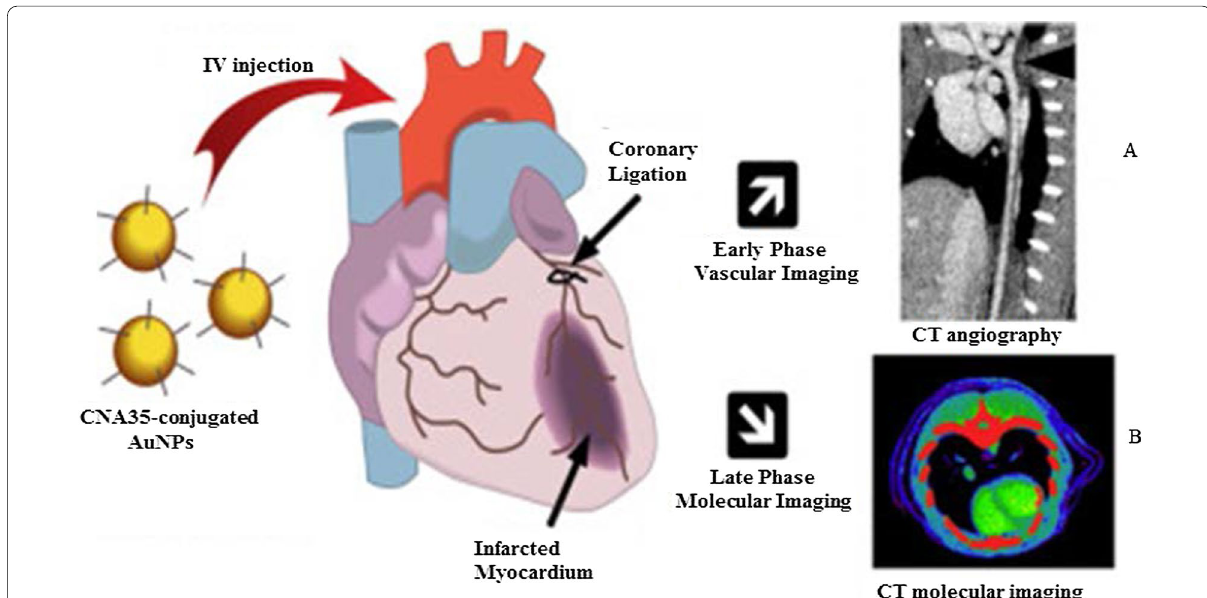
Fig. 5 In vivo CT imaging using AuNPs as CT contrast agents. Mannan-capped AuNPs and their CT imaging of the lymph node ( A ), and CNA35-conjugated AuNPs CT imaging of myocardial scar burden ( B ). Reproduced with permission [79]. Copyright 2018,